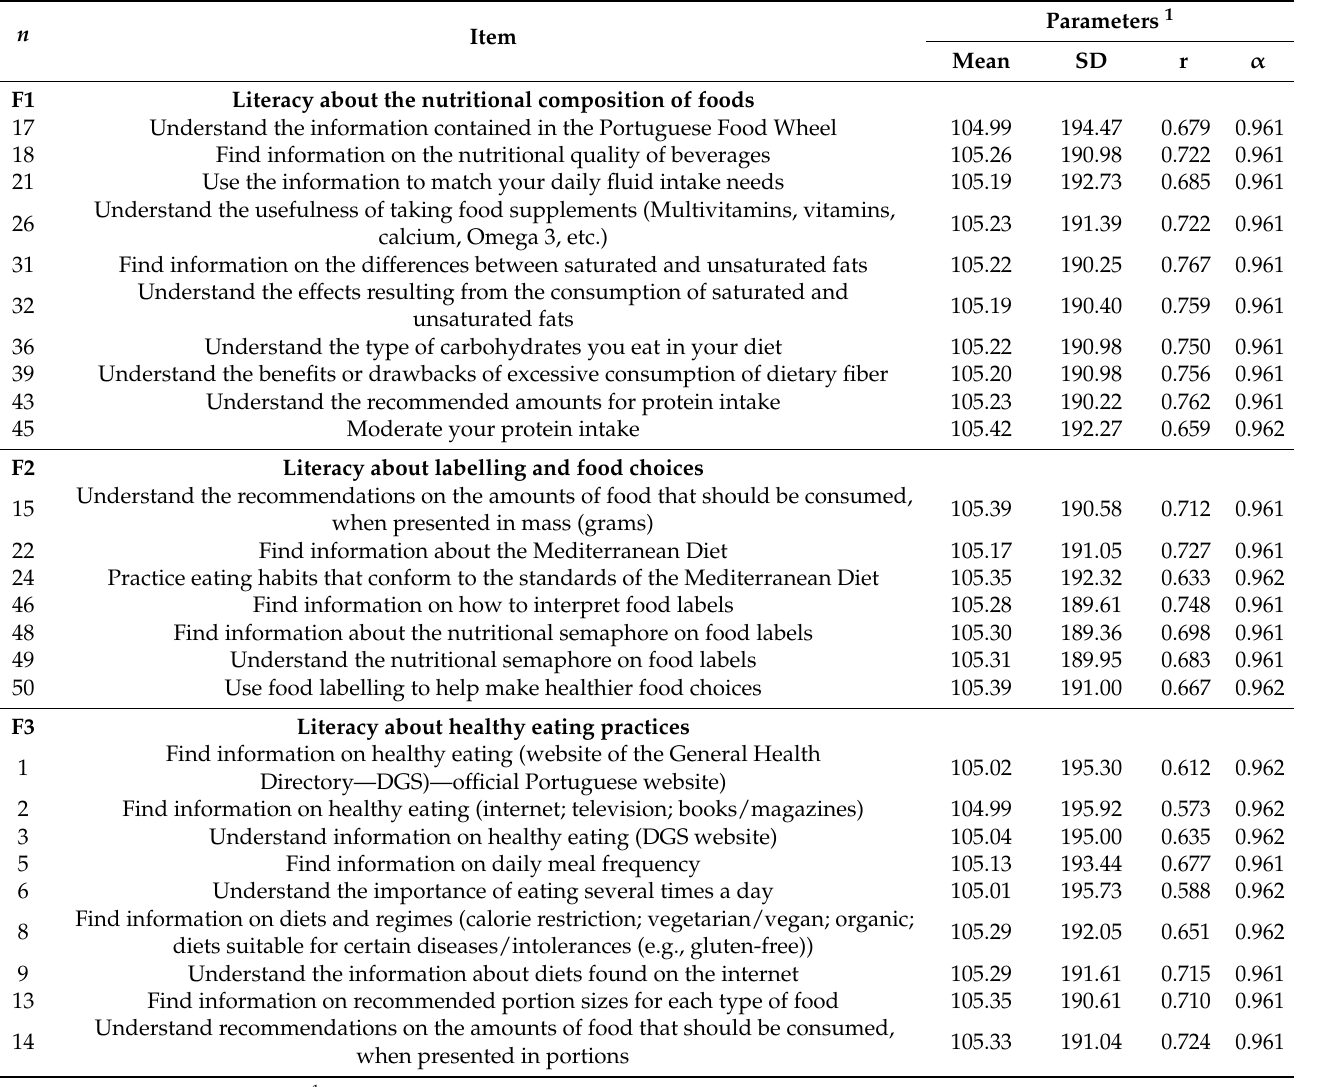
Table 7. Description of items of the second-order model.